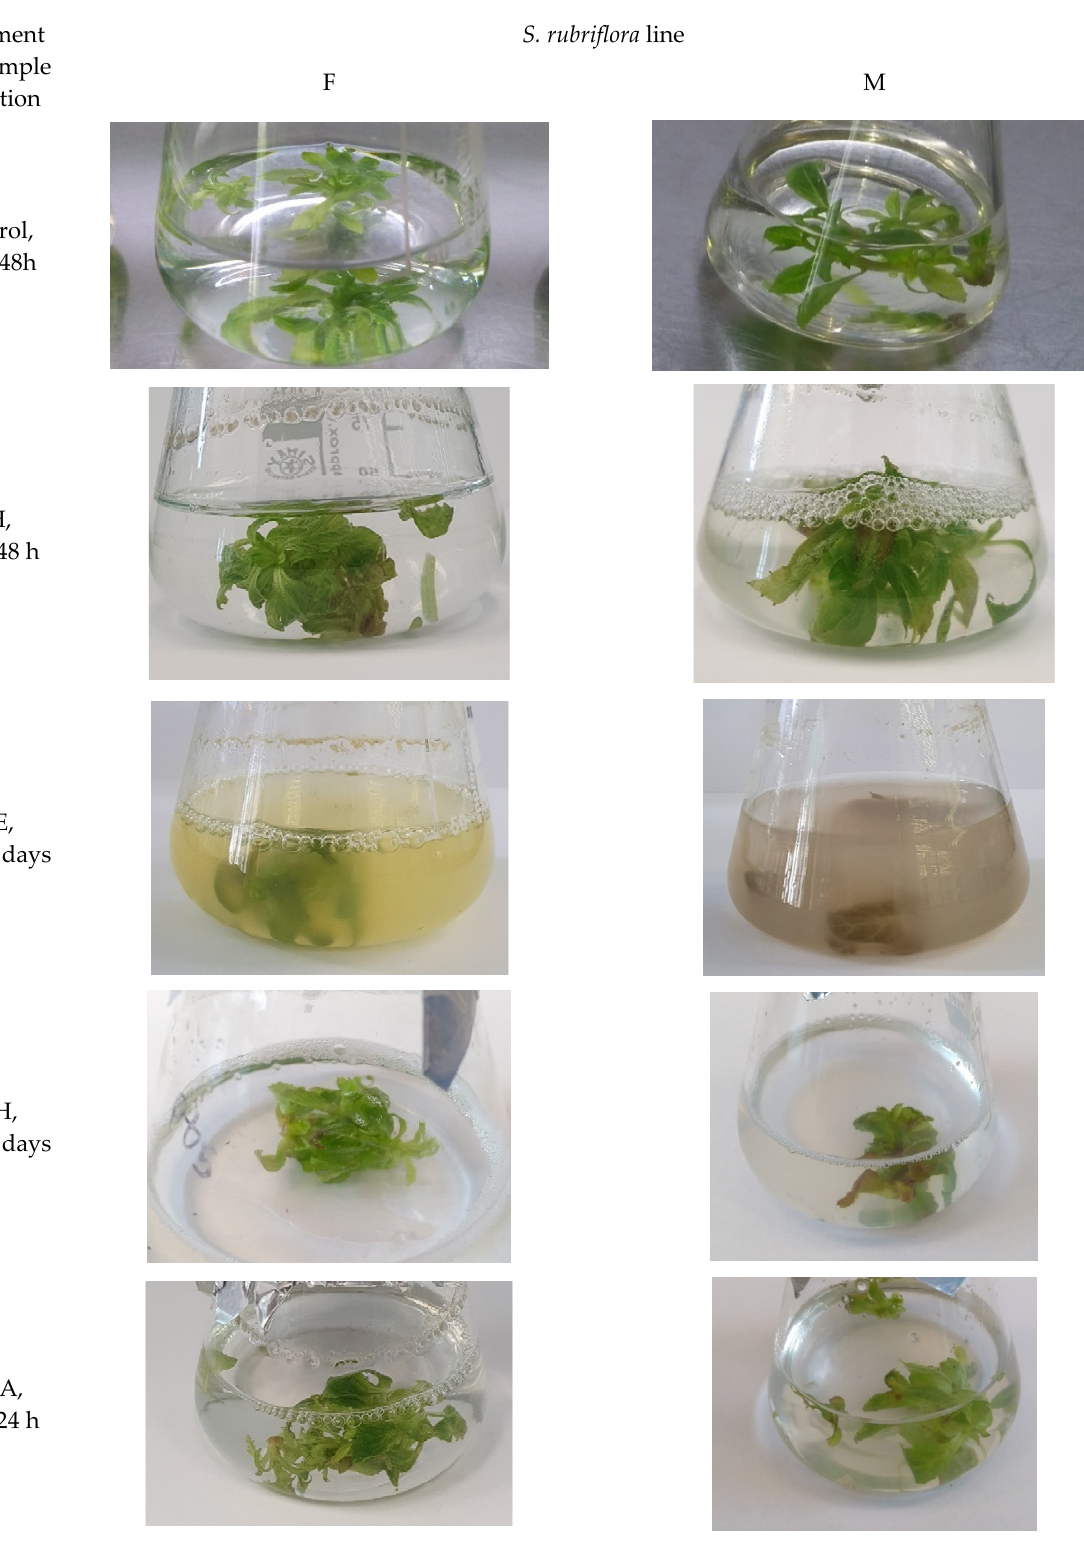
Figure 1. Examples of S. rubriflora agitated microshoot F and M lines appearance–control and after elicitor treatment.